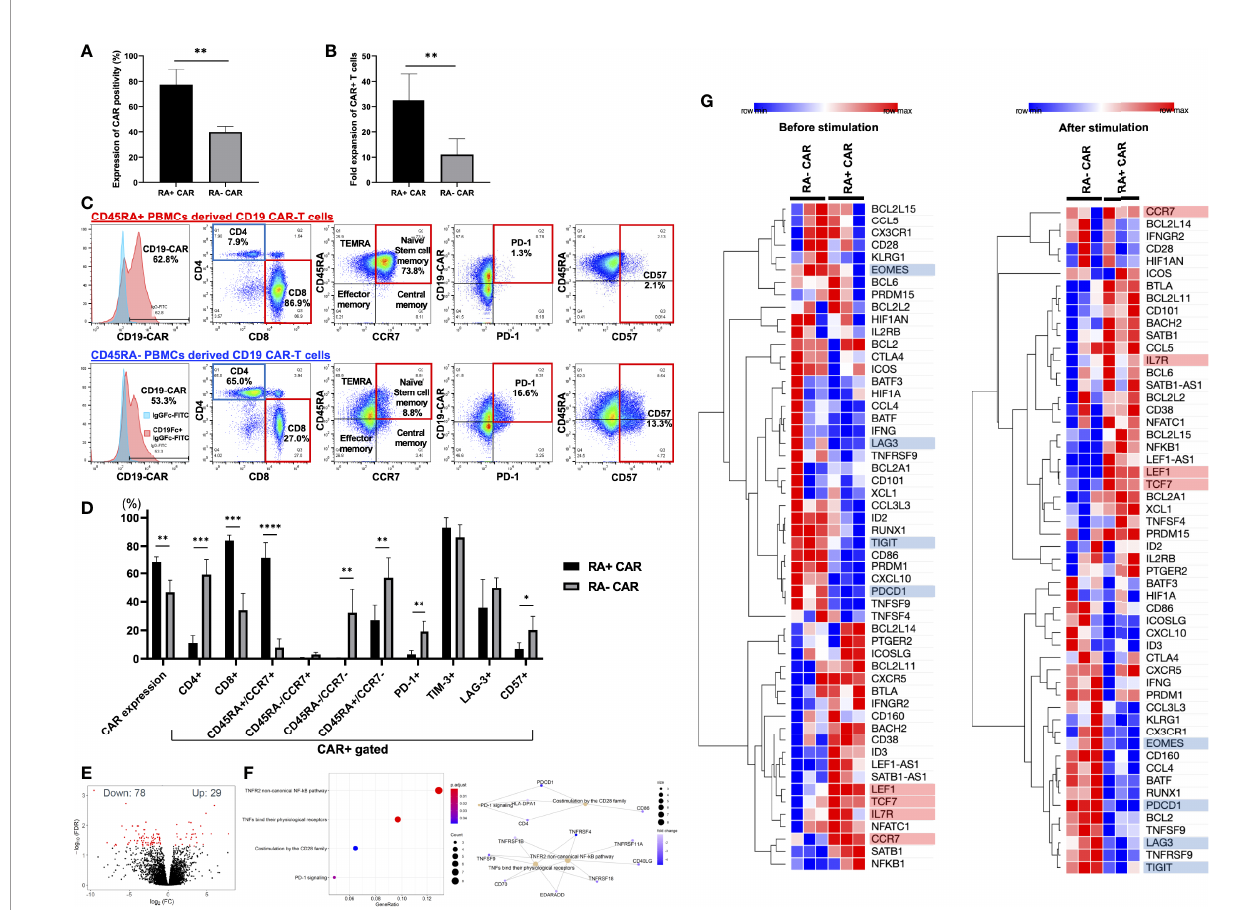
FIGURE 1 | CD45RA + chimeric antigen receptor (CAR)-T cells showed better transient gene transfer ef fi ciency and expansion capacity, dominant CD8 expression, enriched stem cell memory fraction, and less expression of exhaustion-related markers than CD45RA − CAR-T cells. (A) The transient expression of CAR transgene 24 h after gene transfer (n = 3, 3 donors). (B) Number of CAR positive T cells at day 14 (n = 5, 3 donors). (C) Representative expression and phenotypes of CD19 CAR-T, and expression of exhaustion markers on CAR-T cells assessed by fl ow cytometry. The gating control (left, blue) for CAR expression showed CAR-T cells only, stained by anti-human IgG Fc fragment speci fi c antibody conjugated to FITC, the gating of CAR expression (left, red) showed CAR-T cells combined with the recombinant human CD19 Fc chimera protein and secondary stained by anti-human IgG Fc fragment speci fi c antibody conjugated to FITC. (D) The phenotype and exhaustion marker of CD19 CAR-T cells are represented (n = 3 – 6, 3 donors). (E) A volcano plot showing genes with adjusted FDR <0.05 that are differentially expressed in CD45RA + CAR-T compared with CD45RA − CAR-T. (F) Reactome pathway analysis showed that several gene pathways were signi fi cantly downregulated in CD45RA + CAR-T cells compared with CD45RA − CAR-T. Both red and blue circles showed downregulation of gene pathways in CD45RA + CAR-T, and their colors represented adjusted p-values. (G) Transcriptome pro fi ling about expression of T-cell activation genes (highlighted by red underline) and exhaustion genes (highlighted by blue underline) in CD45RA + CAR-T and CD45RA − CAR-T, before antigen stimulation (left) and after antigen stimulation (right). Row min denotes lowest Z-score and row max denotes highest Z-score. All data are presented as means ± standard deviation. *P < 0.05, **P < 0.01, ***P < 0.001, ****P <